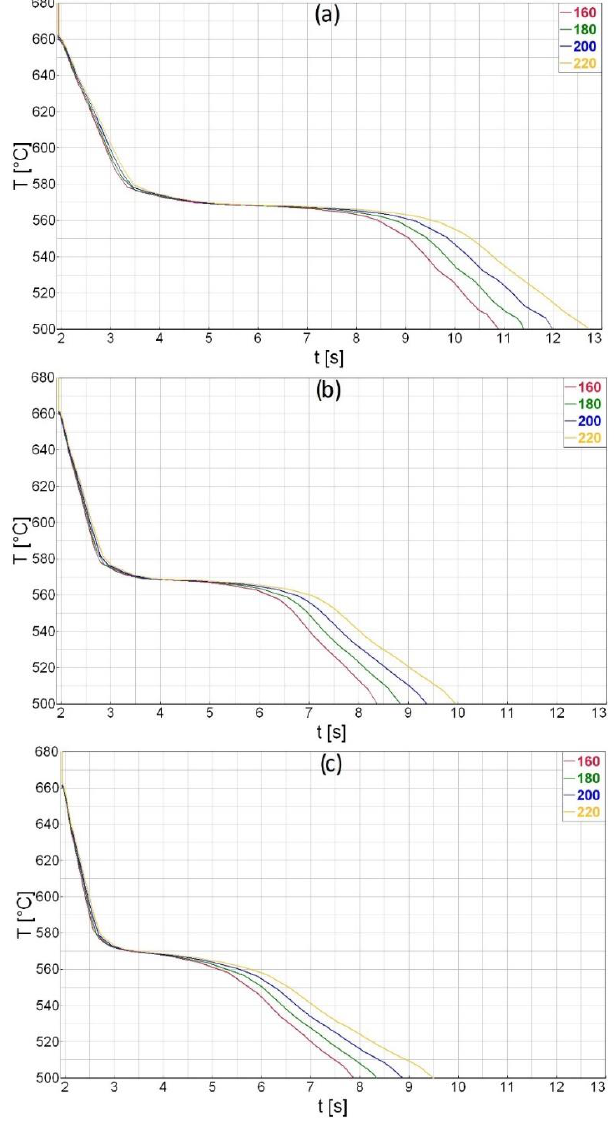
Figure 4. Cooling curves for tool temperatures 160, 180, 200, and 220 °C from the spot of planned: ( a ) large, ( b ) medium, and ( c ) small size samples in dependence with tool temperature acquired by simulation.